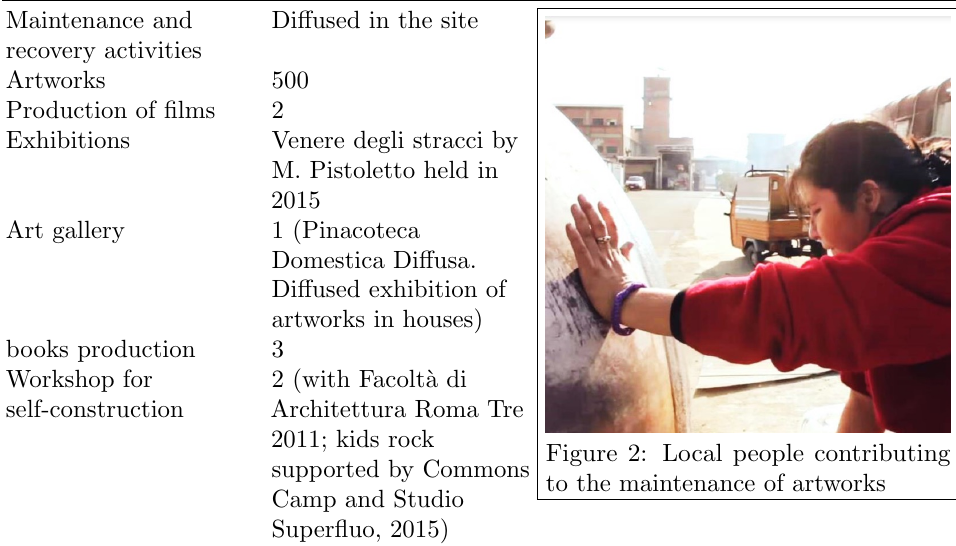
Table 1: actions on built environment